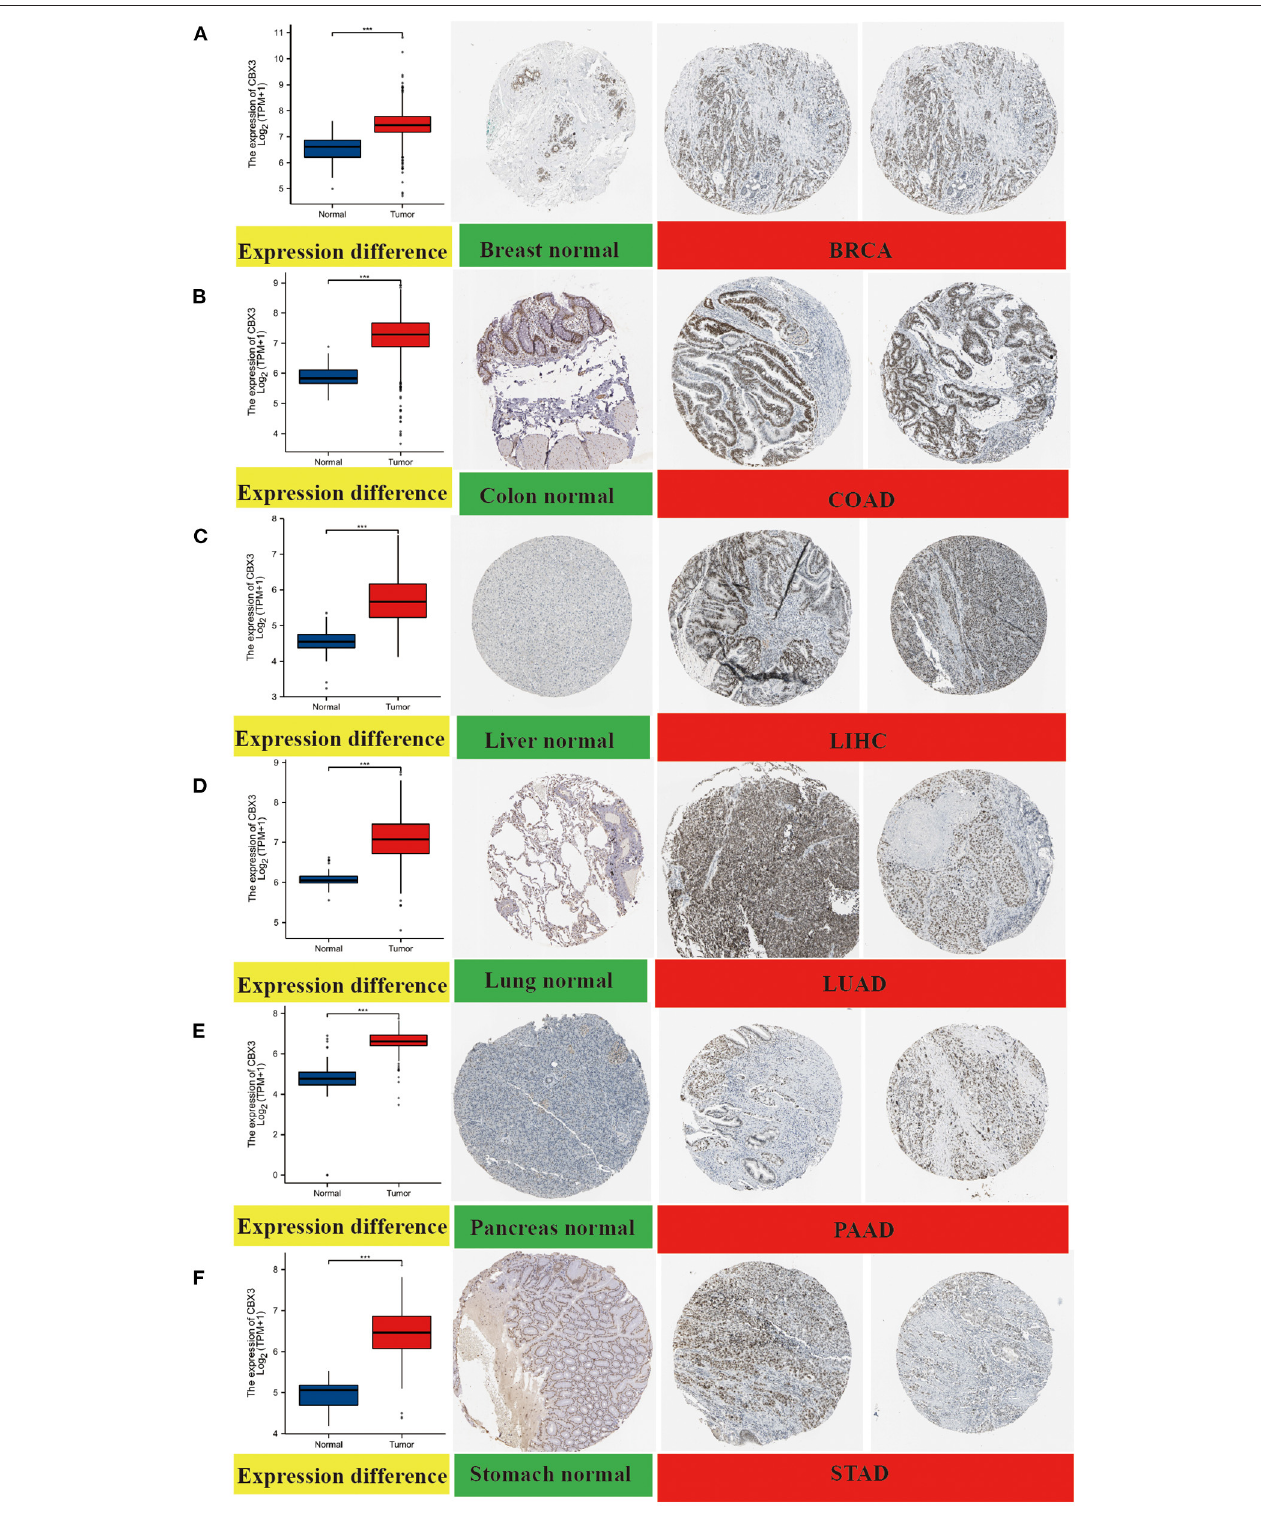
FIGURE 3 | Comparison of CBX3 gene expression between non-tumor normal tissues and tumor tissues (left) and immunohistochemical images of normal tissues (middle) and tumor tissues (right). The expression of CBX3 protein in BRCA, COAD, LIHC, LUA), PAAD and STAD was considerably elevated as opposed to that in non-tumor normal tissues. (A) breast, (B) colon, (C) liver, (D) lung, (E) pancreas, (F) stomach. *** P < 0.001.